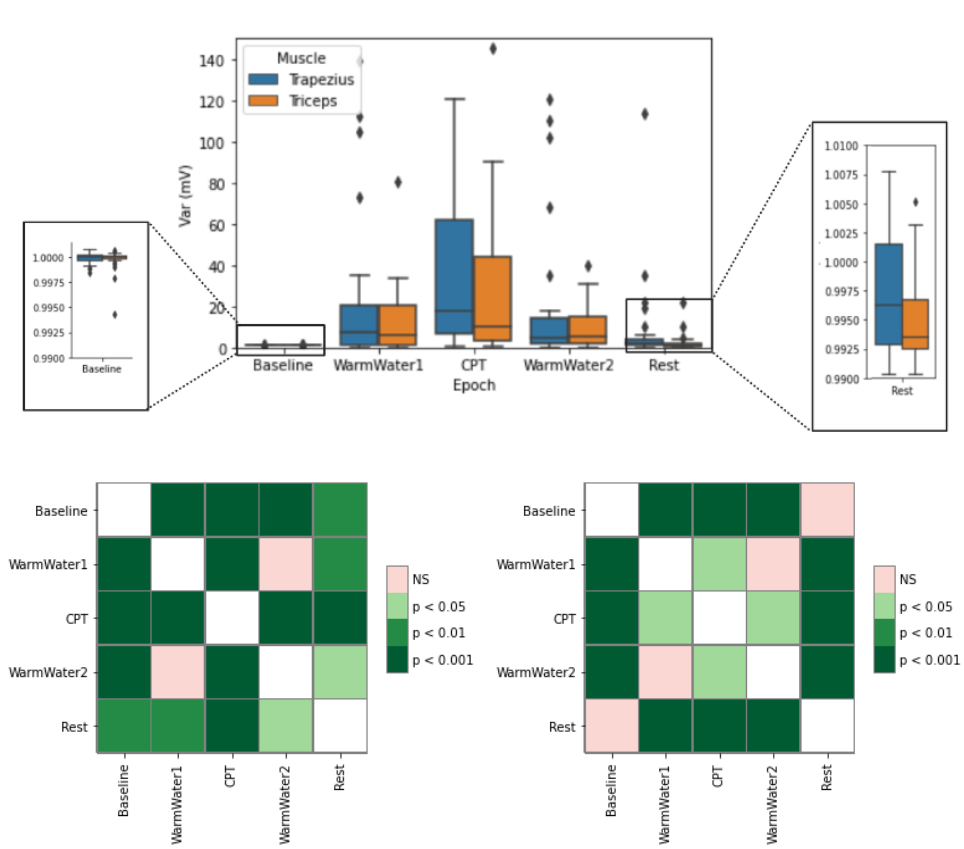
Figure 11. Boxplot of VAR for the trapezius and triceps muscle ( top ) with respective statistical analysis, with p -values, with Bonferroni correction, for the trapezius ( bottom left ) and triceps ( bottom right ). The (cid:5) stands for